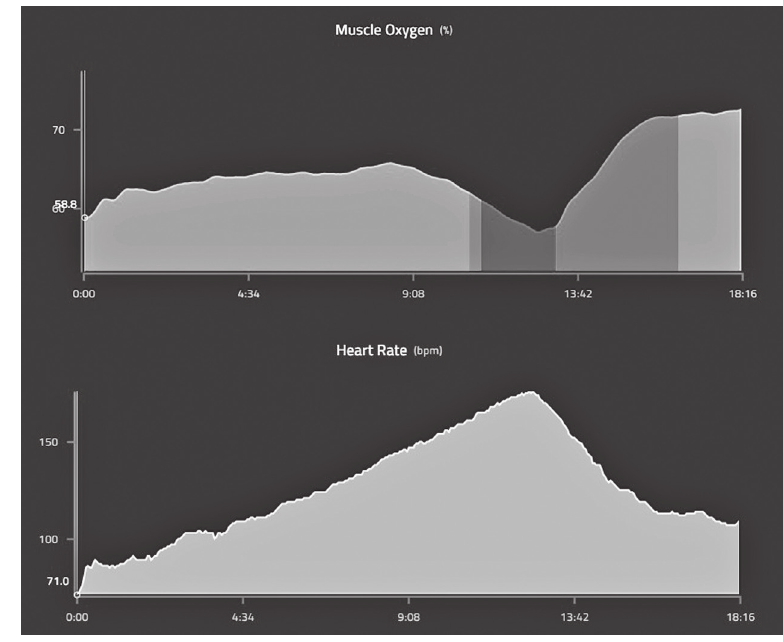
FIGURE 2. Heart rate and SmO